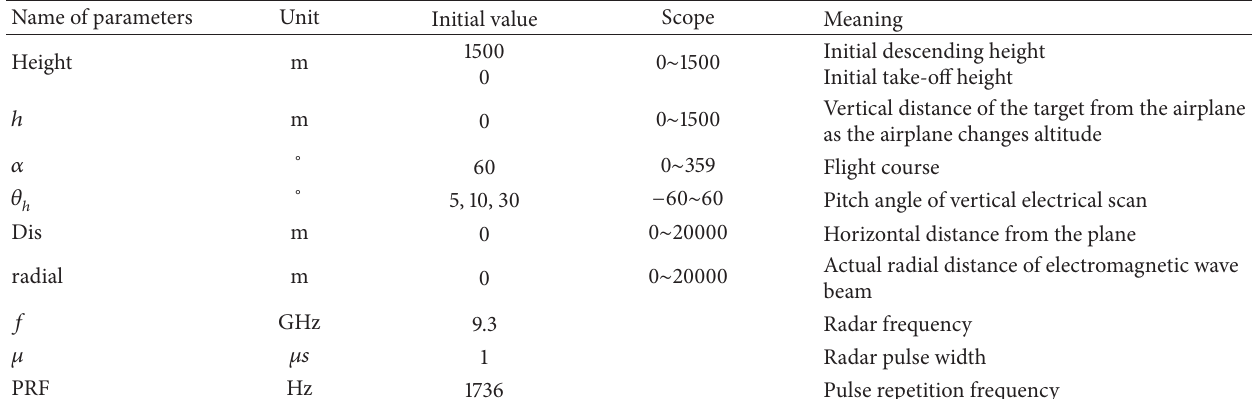
Table 1: Initial flight parameters and radar parameters.